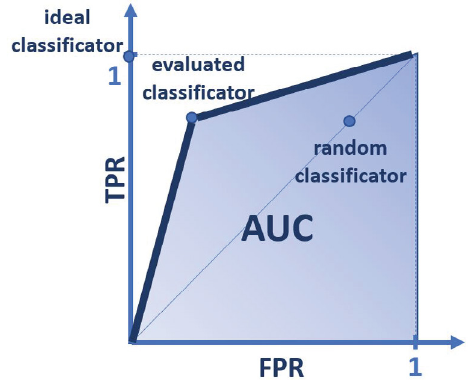
Fig. 5. ROC curve (source: A. Fiedukowicz